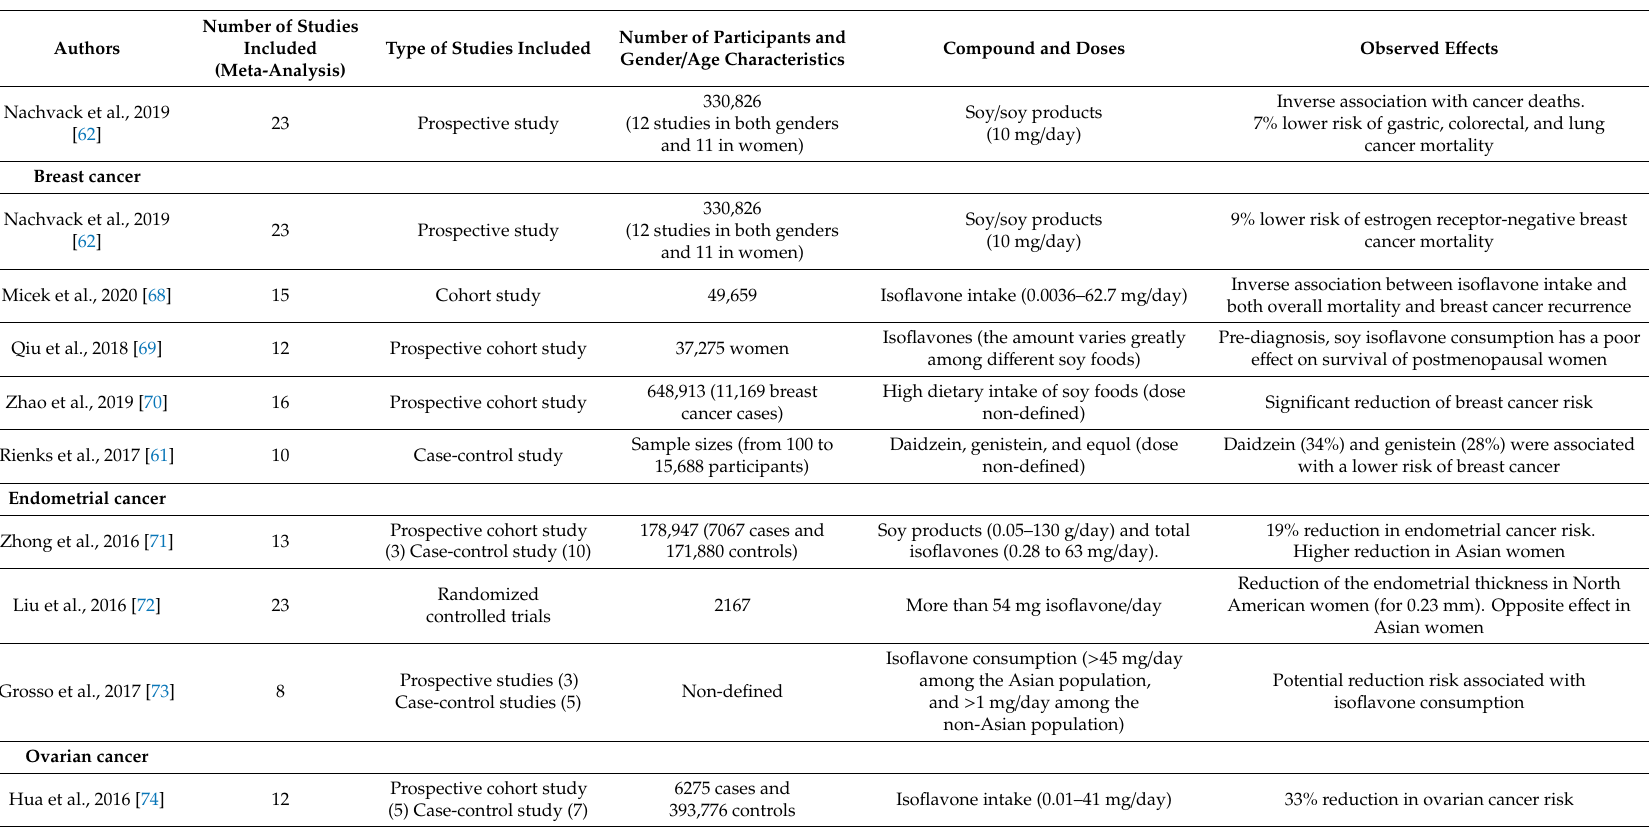
Table 4. E ff ects of isoflavones in di ff erent cancer